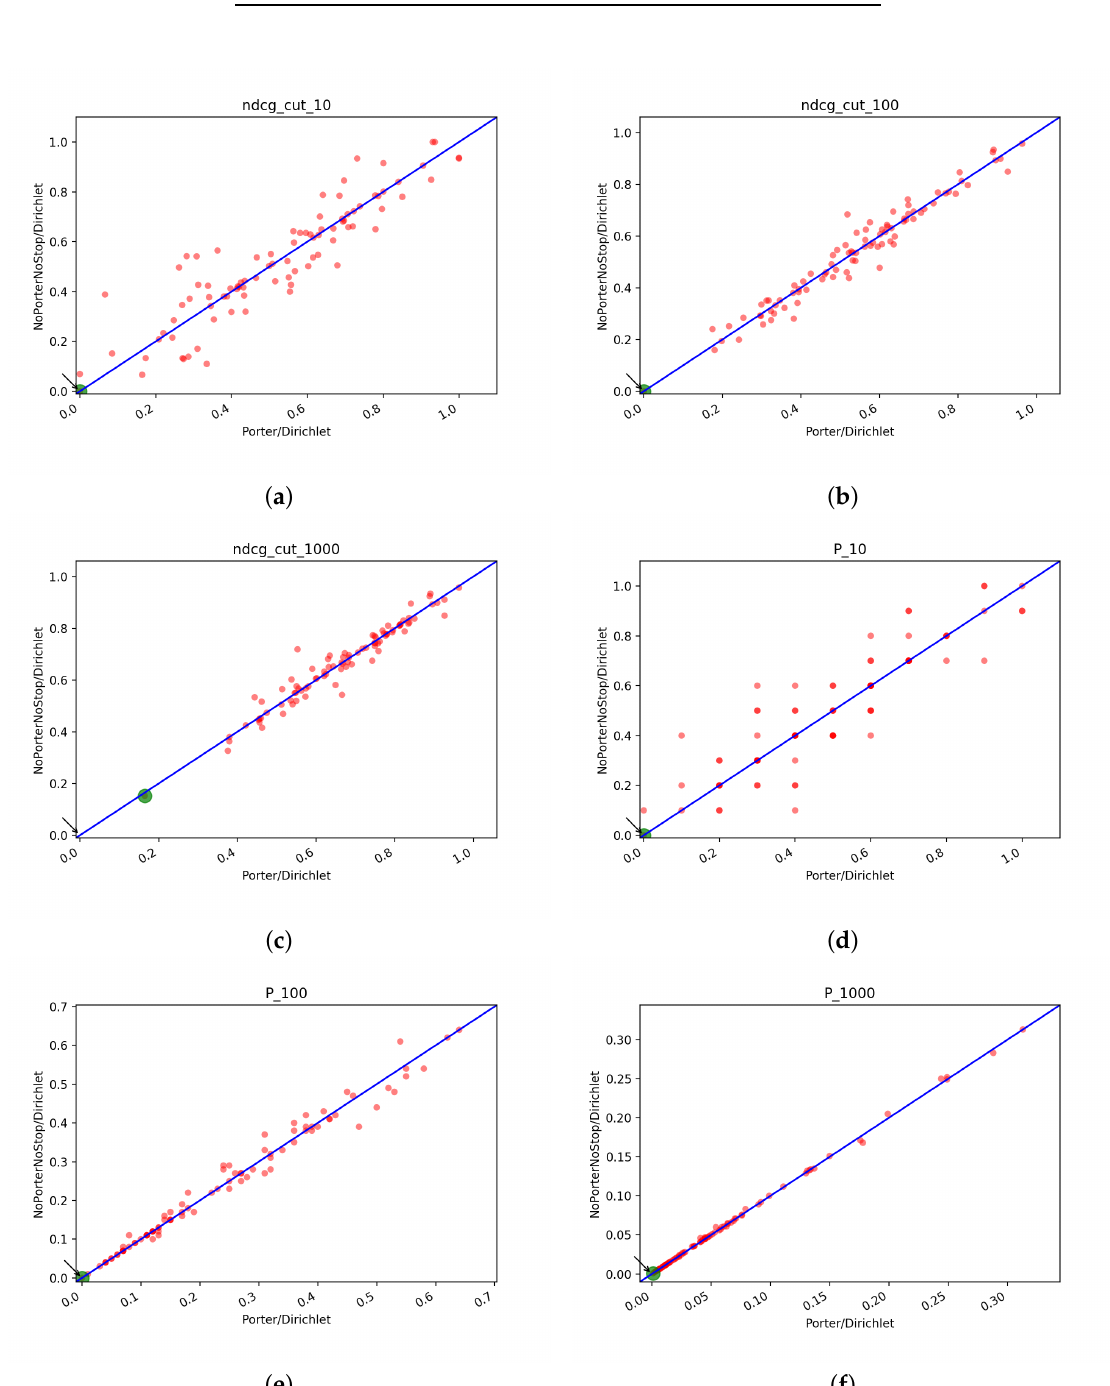
Figure 16. T2: scatter plots for Porter/Dirichlet vs. NoPorterNoStop/Dirichlet with QE+RF: box plots of P@10 of the fusion methods: ( a ) NDCG@10, ( b ) NDCG@100, ( c ) NDCG@1000, ( d ) Precision@10, ( e ) Precision@100, ( f )